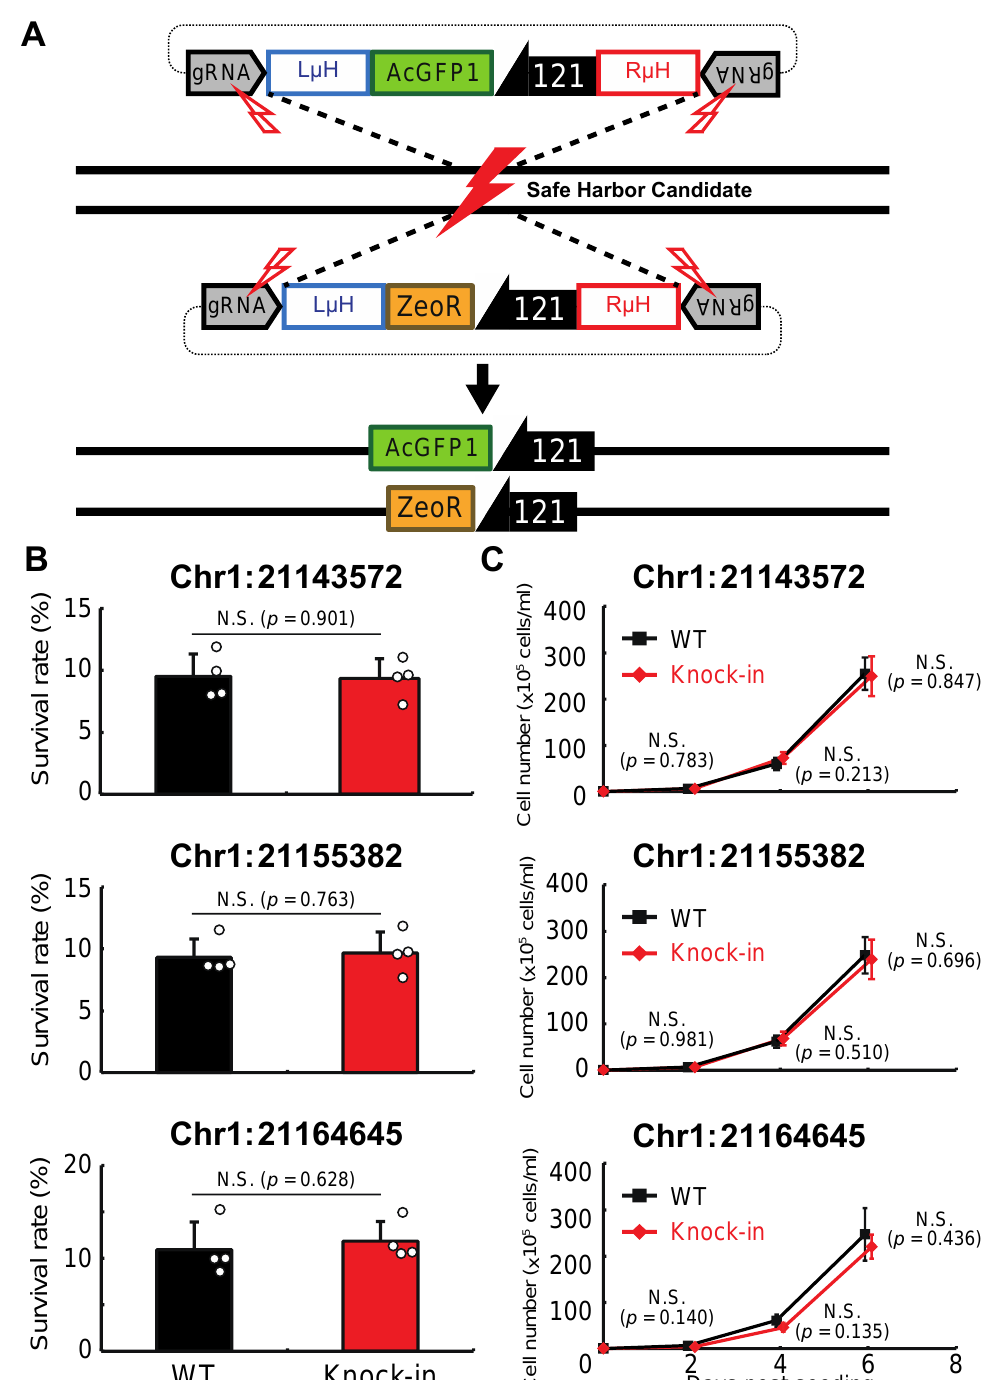
Figure 3. Integration of the expression units of AcGFP1 and zeocin-resistance (ZeoR) genes into GSH candidates. ( A ) The knock-in scheme for AcGFP1 and ZeoR expression units is shown; the donor vectors harboring AcGFP1 and ZeoR genes under control of the 121 promoter were transfected into Pv11 cells. ( B ) The survival rate after desiccation–rehydration treatment is shown for each knock-in cell line. ( C ) The proliferation rate of the knock-in cell lines is shown. Values are expressed as mean ± SD; n = 4 in each group. N.S., not significant.